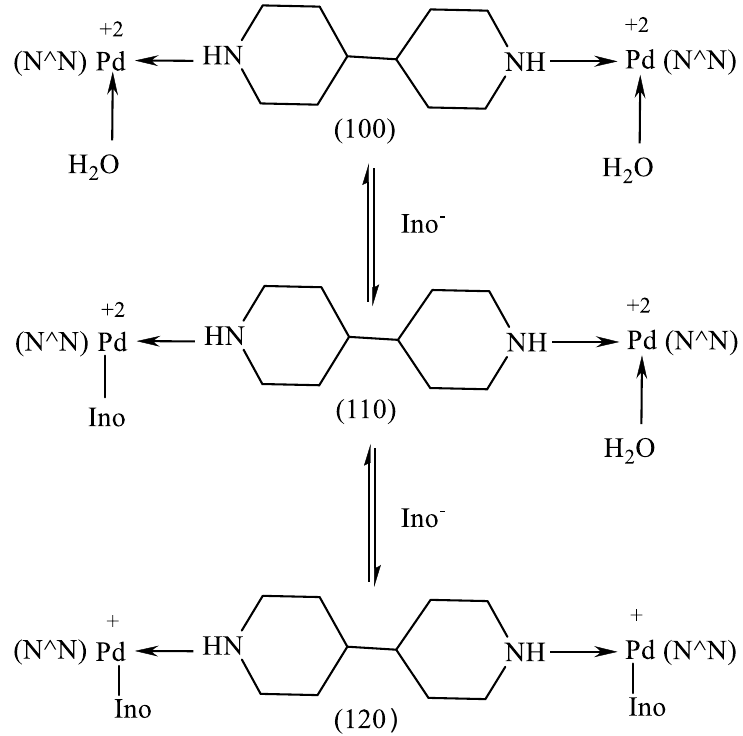
Scheme 6. The hydrolysis of the binuclear complex.